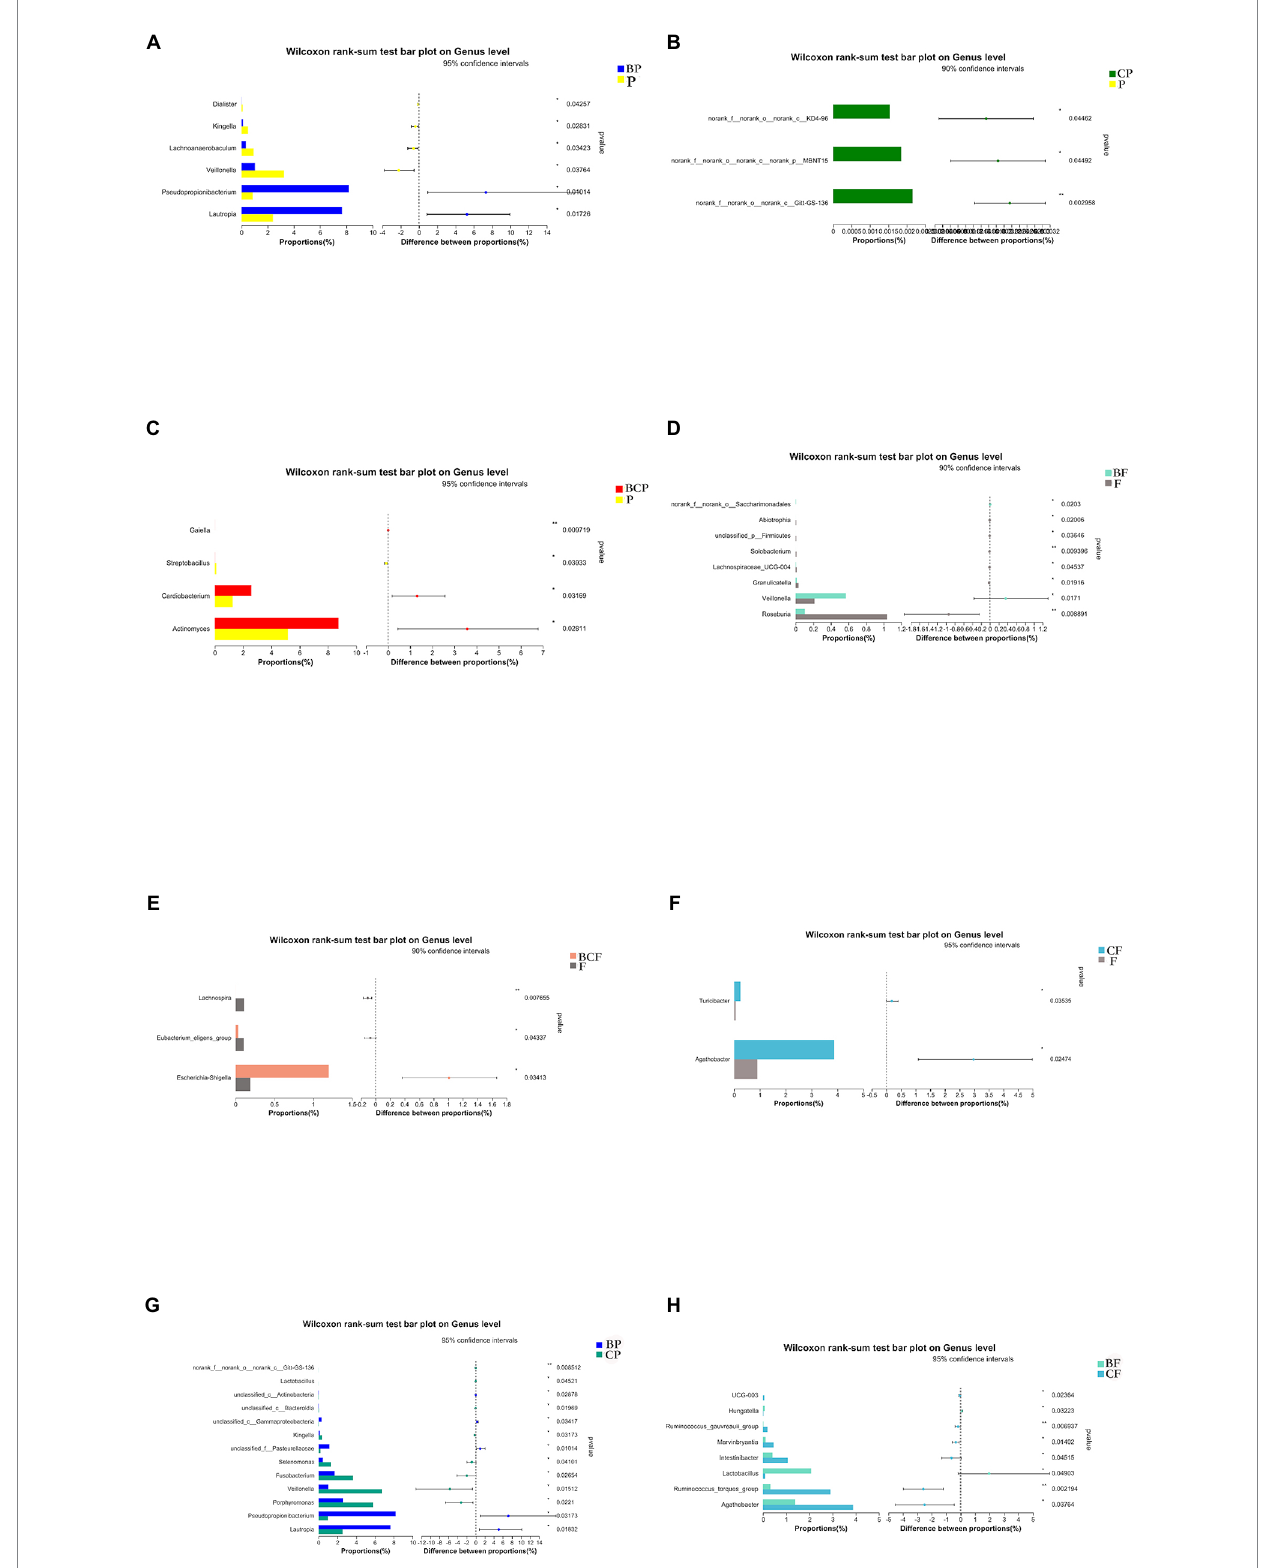
FIGURE 5 Plots based on the Wilcoxon rank-sum test at the genus level. Results of the comparison of (A) BP and P, (B) CP and P, (C) BCP and P, (D) BF and F, (E) BCF and F, (F) CF and F, (G) BP and CP, and (H) BF and CF groups. * p < 0.05, ** p < 0.01, *** p <